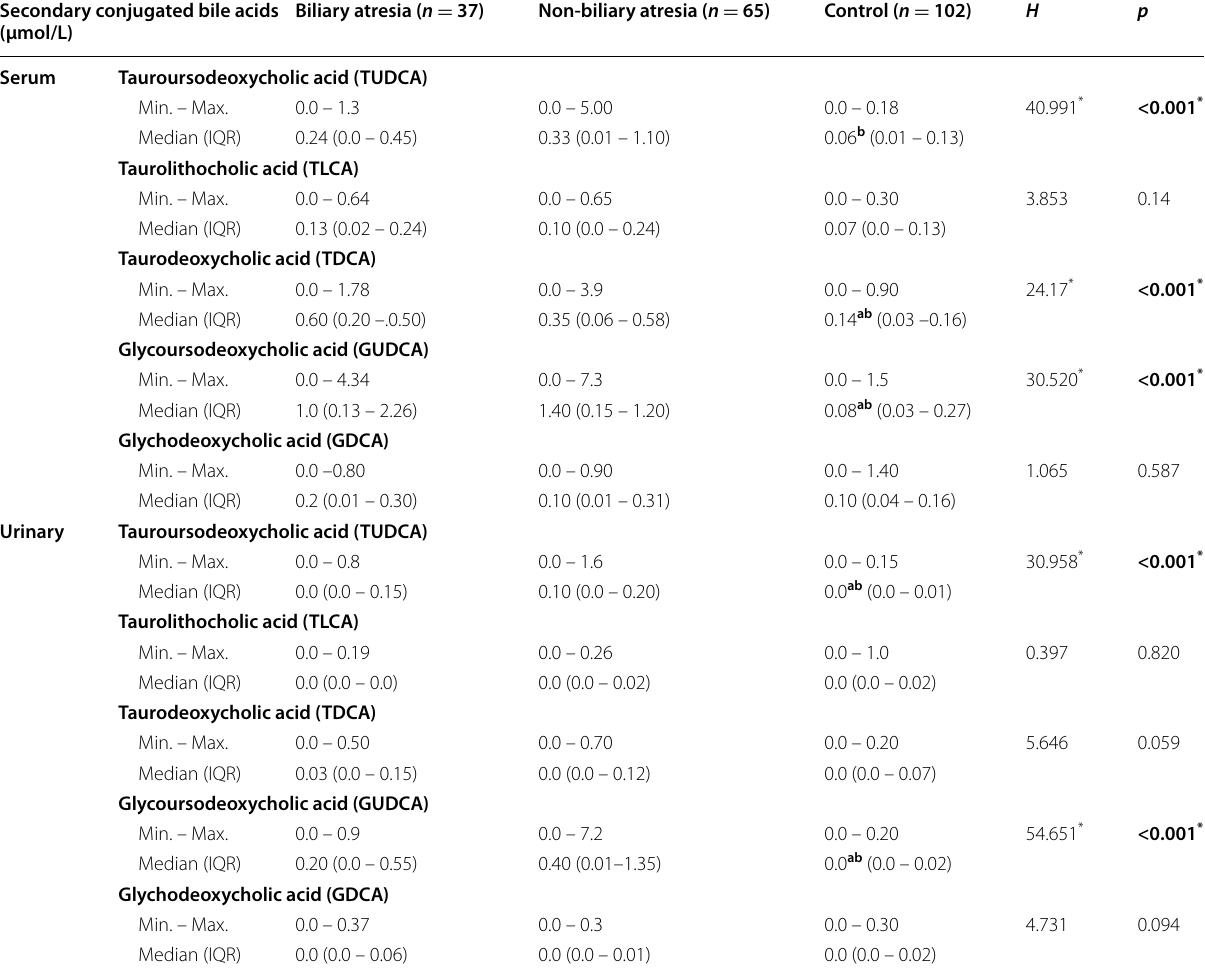
Table 7 Comparison between the two cholestatic groups (BA & non‑BA) and control regarding secondary conjugated bile acids in serum and urine (μmol/L) Secondary conjugated bile acids Biliary atresia ( n = (μmol/L)